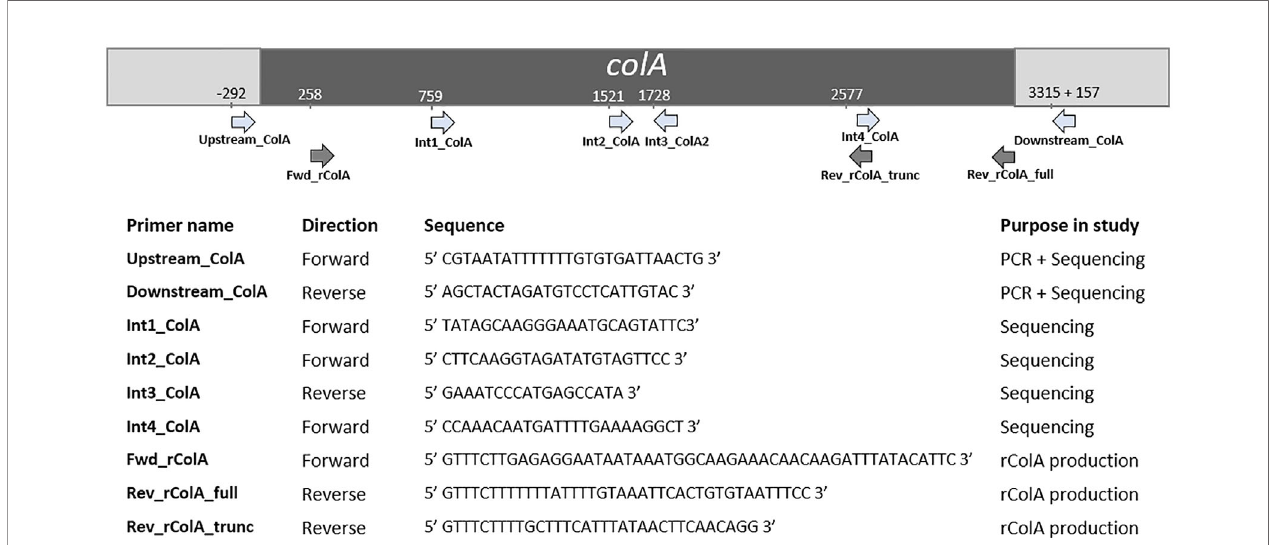
FIGURE 1 | Primers used in this study and their relative position in colA. Positions are based on C. perfringens strain EHE-NE18 colA